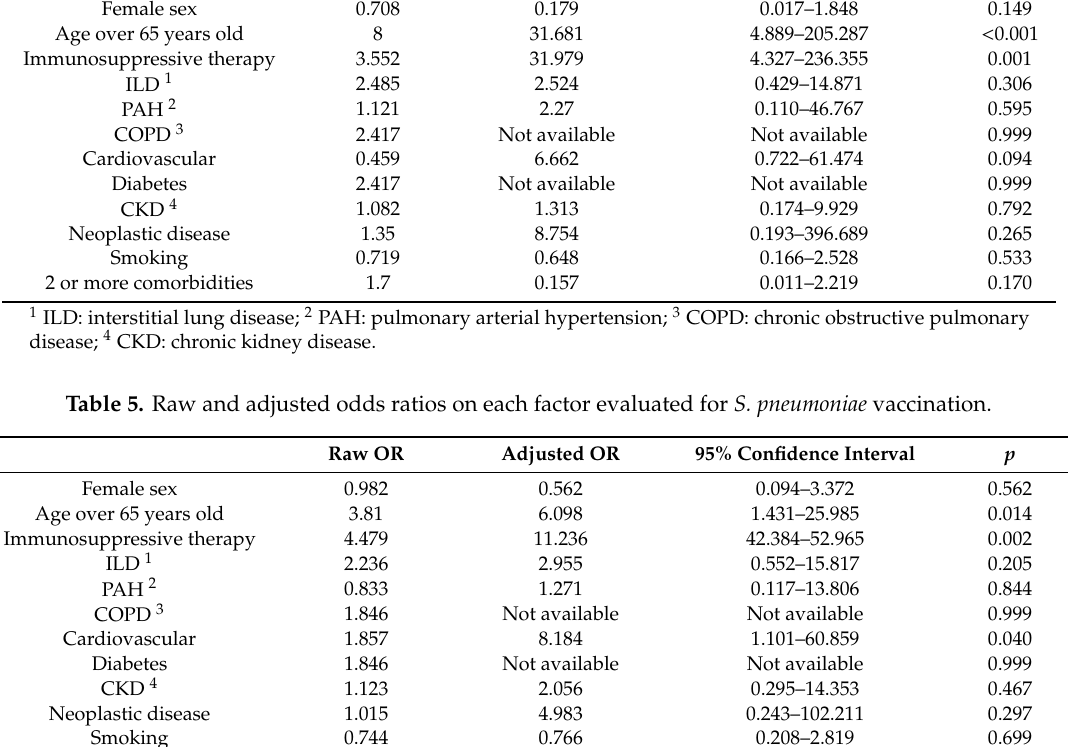
Not available Not